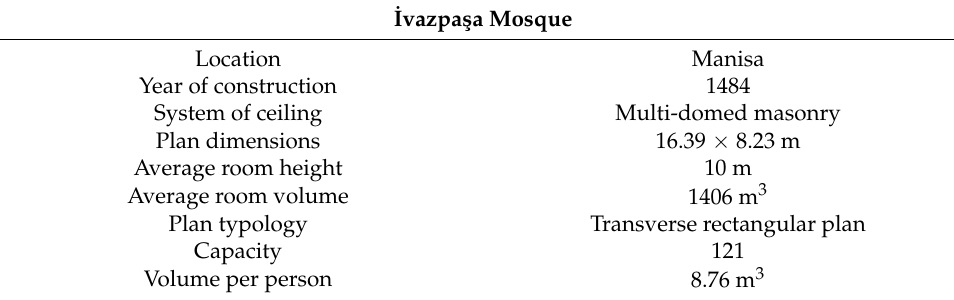
Table 2. The architectural features of İ vazpa ş a Mosque.